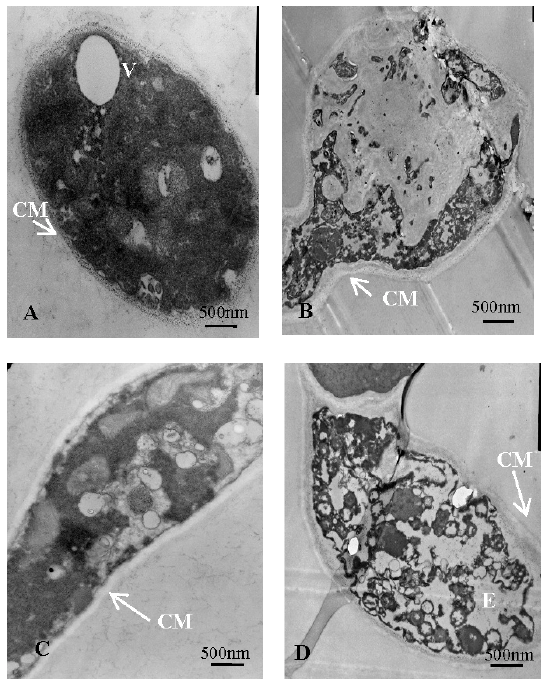
Figure 8. Transmission electron microscopy images of untreated and treated V. mali hyphal structures ( × 10 k). ( A ) Horizontal and ( C ) vertical sections of untreated hyphal structures show regular, uniform cytoplasm; ( B ) Horizontal and ( D ) vertical sections of structures following 40 µ g/mL (working concentration) cembranoids extract treatment. It can be observed that the cell wall became distorted, the plasma membrane was unevenly thickened, and the intracellular composition was disordered.